Question: According to the figure, is the described quantity increasing or decreasing?
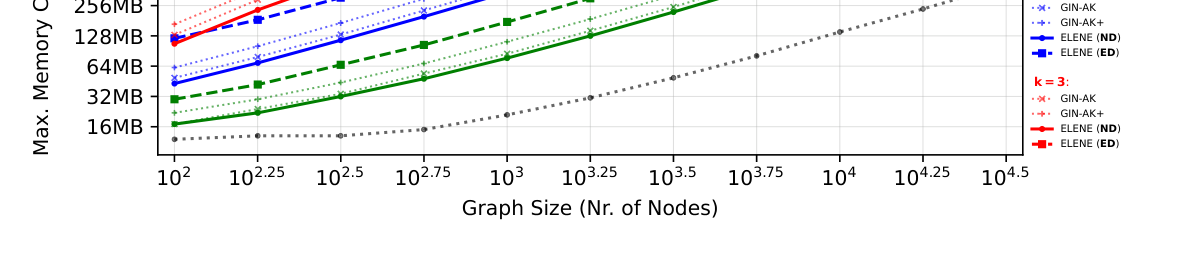
Answer: increasing